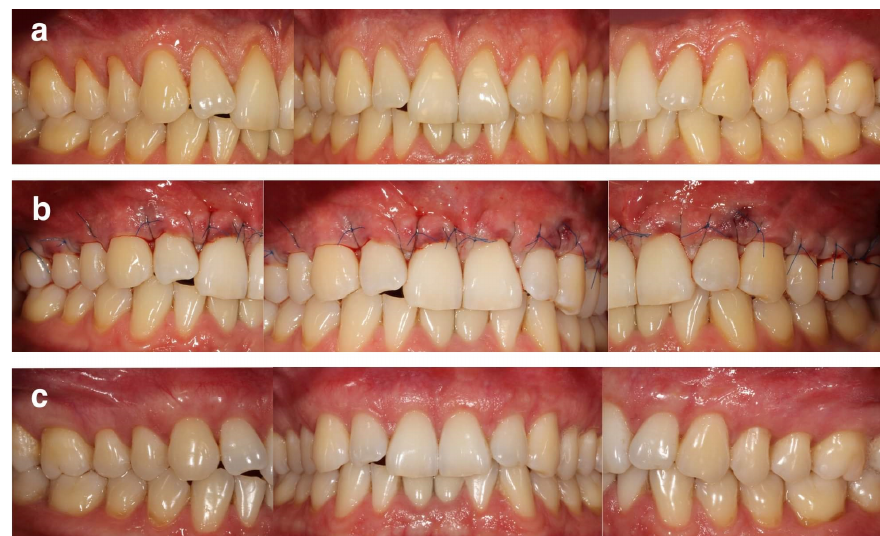
Figure 1. Representative case of symmetrical multiple gingival recessions at maxillary teeth ( a ) pre- operative view of gingival recessions; ( b ) immediate post-operative view; ( c ) 24 months post-operative view.